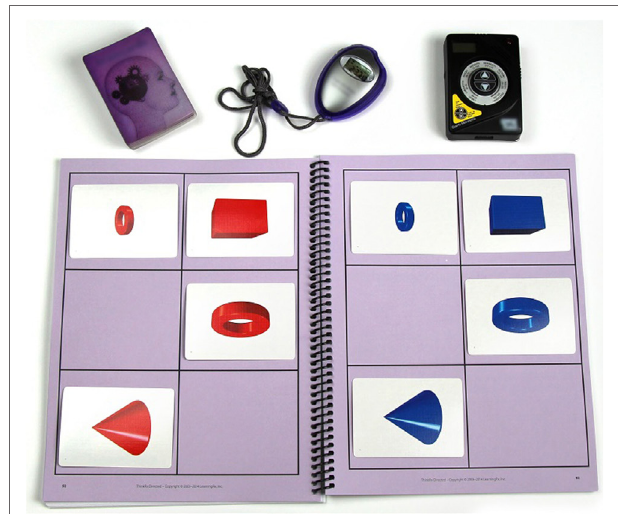
FigUre 1 | Example of a working memory training